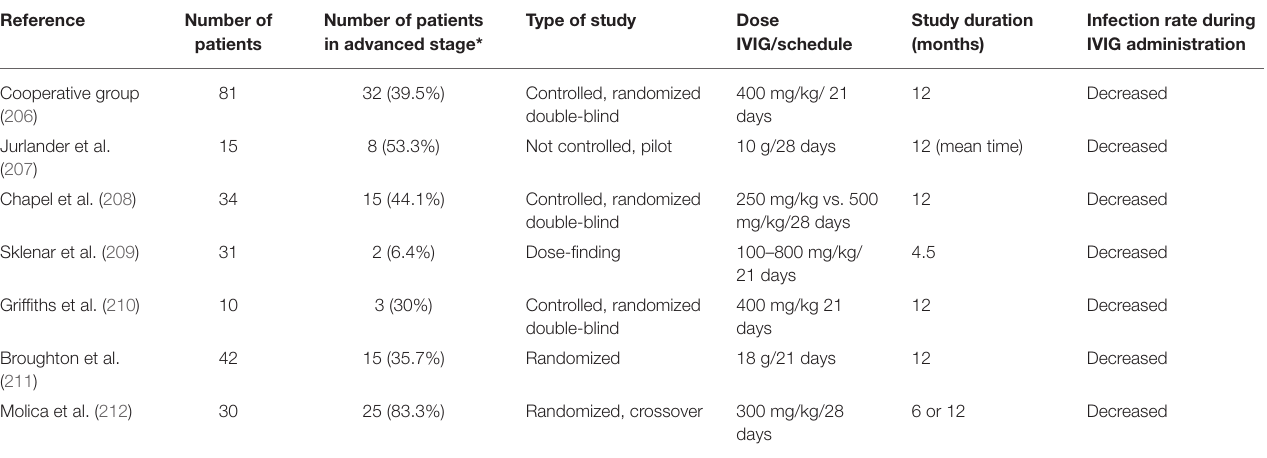
TABLE 4 | Summary of evidence for the use of immunoglobulin replacement therapy in